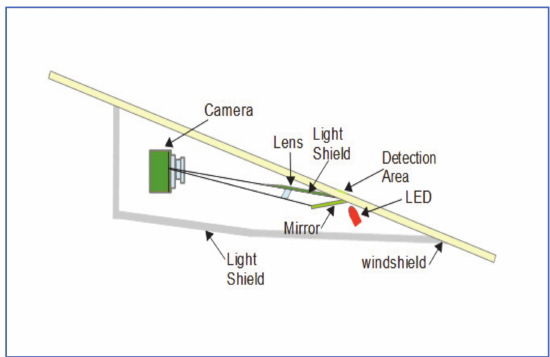
Figure 2. Raindrop detection system using a dedicated camera [13].